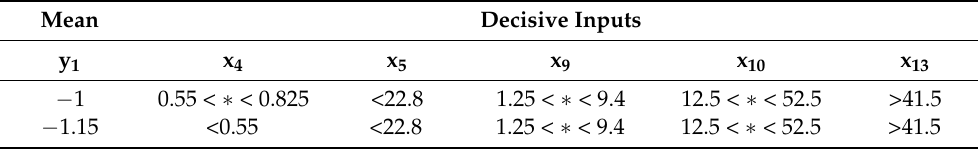
Figure 8. Regression tree analyzing the dependence of the normalized combined output y 123 on the furnace design and process parameters x 1 –x 13 . In the case of doped Ge, the branch where leaf node has a minimal mean value y 123 ∼ 0.858 (-) is favorable. The RMSE for each split is given in Table A2 in Appendix A. Table 5. The most decisive inputs and their optimal values for the favorable y 123 value, derived from RT analysis. The data ranges correspond to the white nodes in Figure 8.